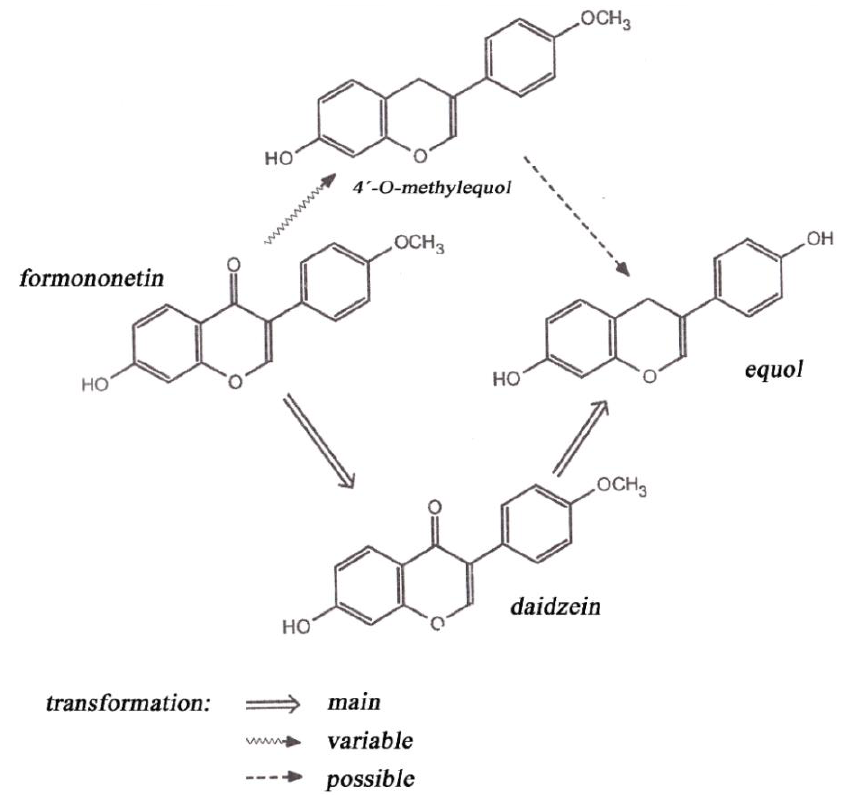
Figure 1. Formononetin metabolism in sheep.